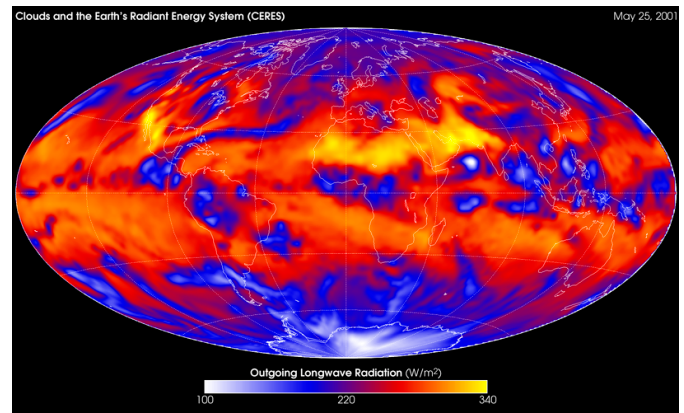
Figure 1. Radiation budget instrument (RBI) [3] scan pattern.